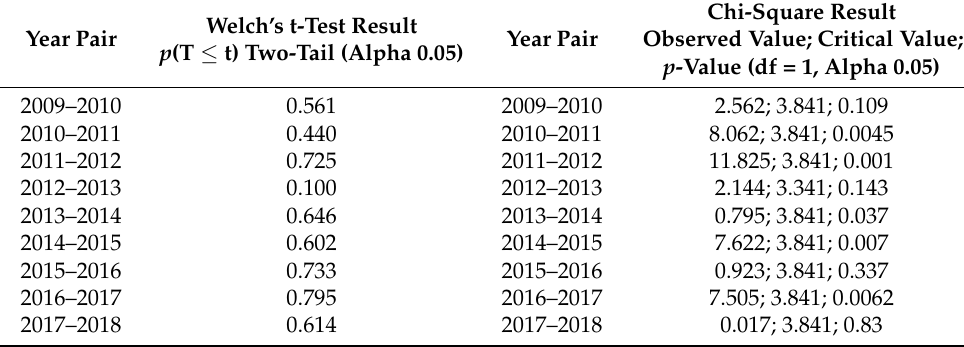
Table 3. Summary of the Welch’s t-test and the Chi-square